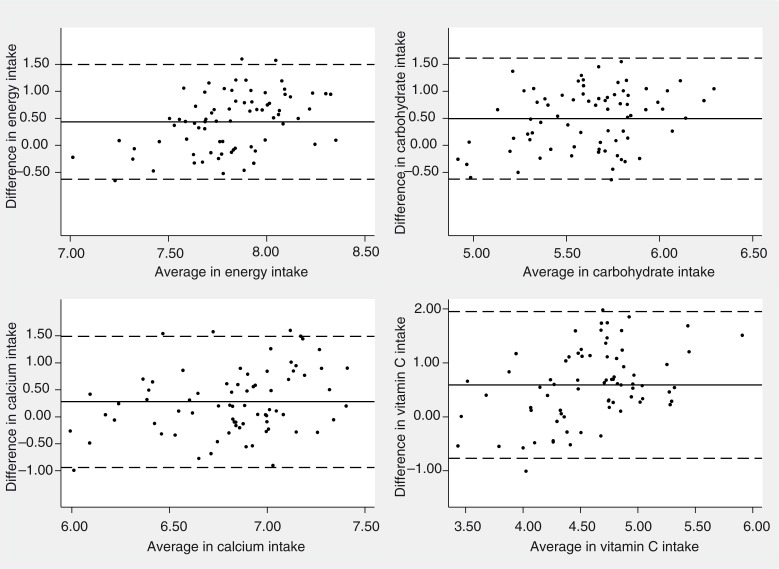
Bland–Altman for the comparative validity analysis of energy, carbohydrate, calcium, and vitamin C. The solid horizontal lines indicate the mean difference between the two methods and the broken horizontal lines indicate the lower and upper Limits of Agreement (±t91;
0.025SDs).